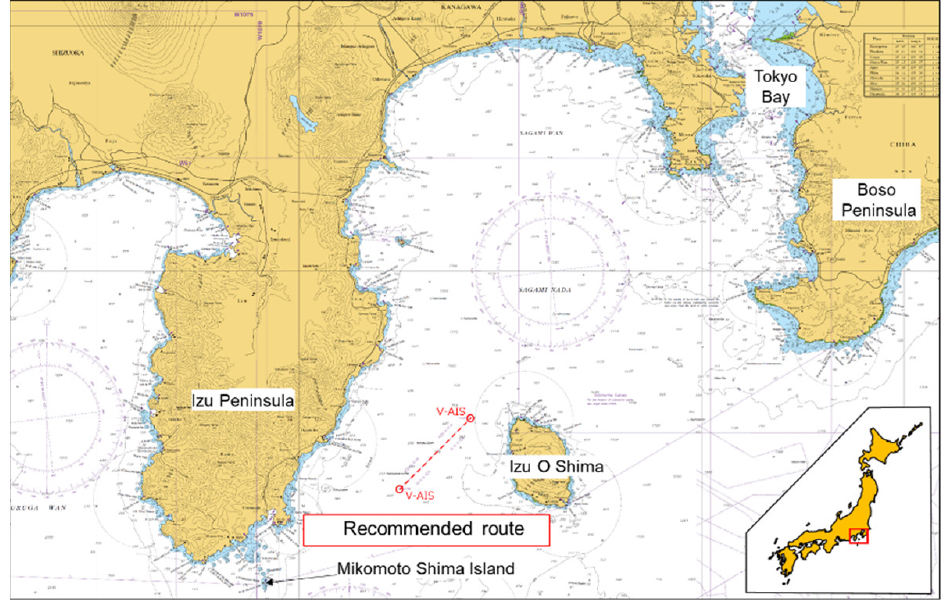
Figure 1. RR off the western coast of Izu O Shima Island (provided by the Japan Coast Guard (JCG)).